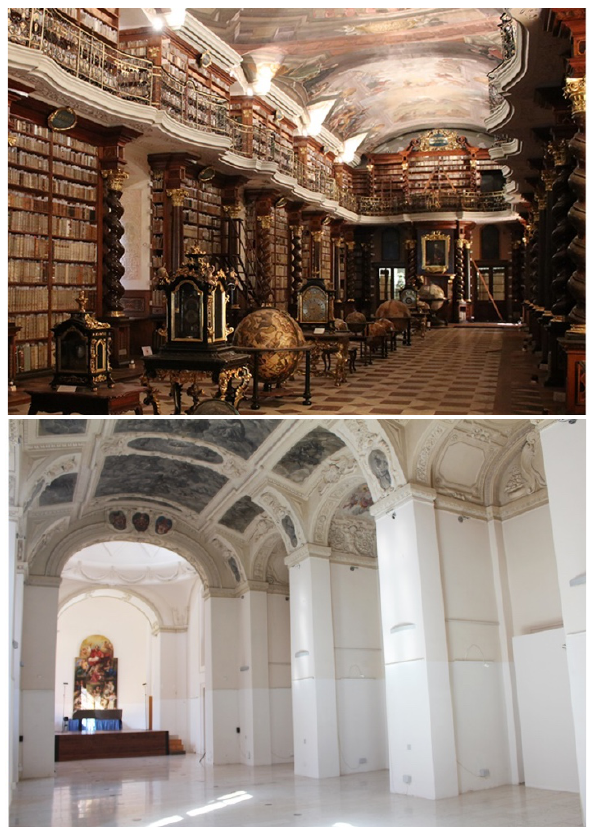
Figure 1. The Klementinum Baroque Library (top) and the Italian Cultural Institute